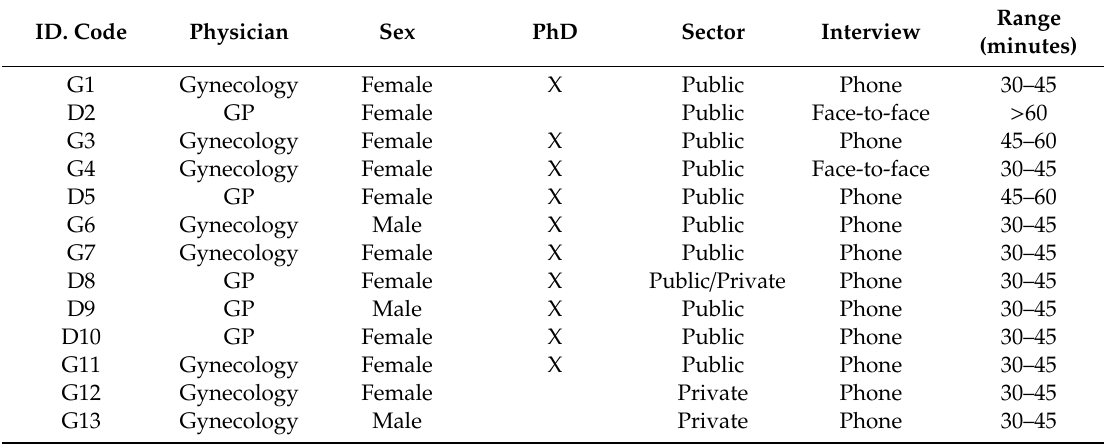
Table 1. Characterization of the sample and duration of interviews.